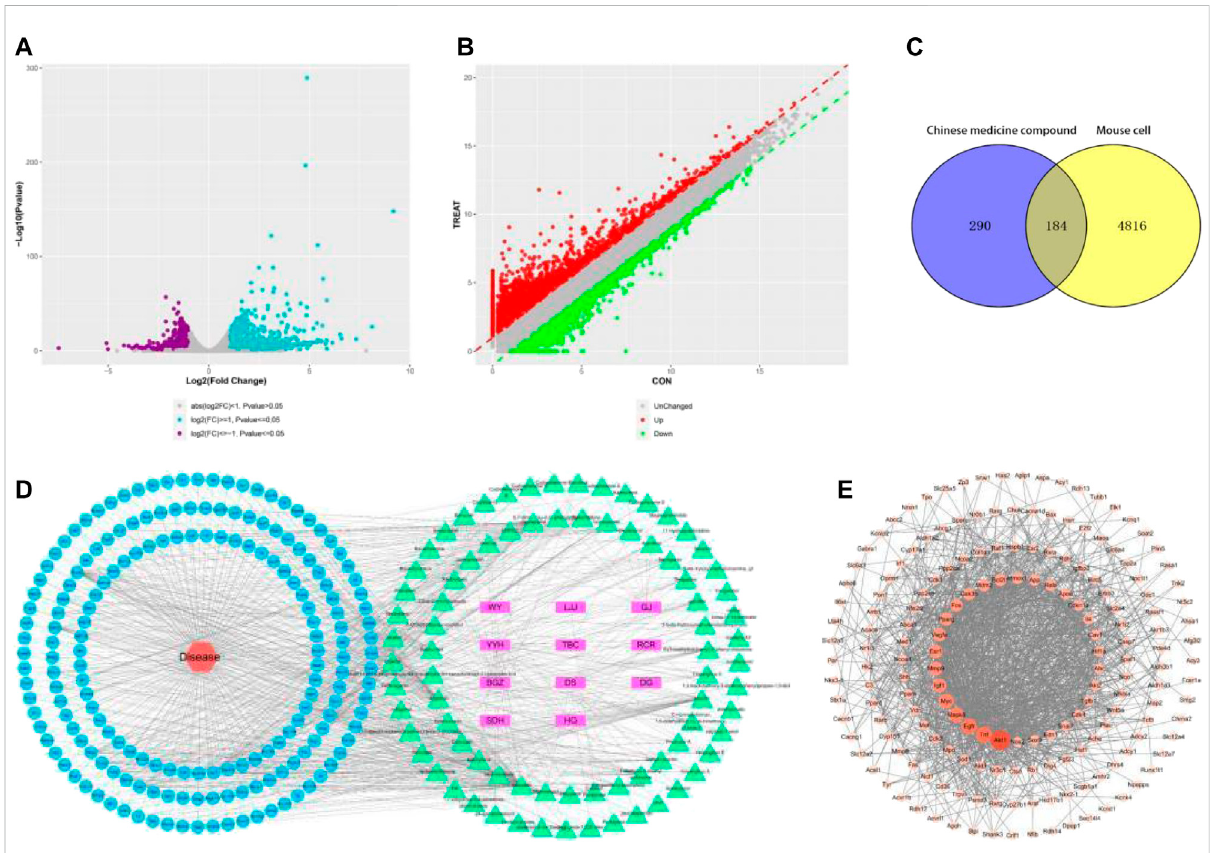
FIGURE 2 (A) Volcanicdiagrambetweentwogroupsofsamples; (B) Scatterplotbetweentwogroupsofsamples; (C) Drug-cellgenecommontargets; (D) Drug-component-target-gene interaction network diagram; (E) Protein interaction